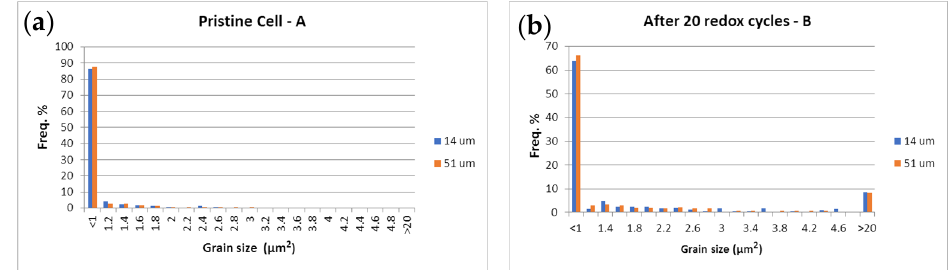
Figure 15. Ni grain size surface distribution (µm 2 ) at 14 µm ( ■ ) and 51 µm ( ■ ) from the anode/elec- Figure 15. Cont . trolyte interface.